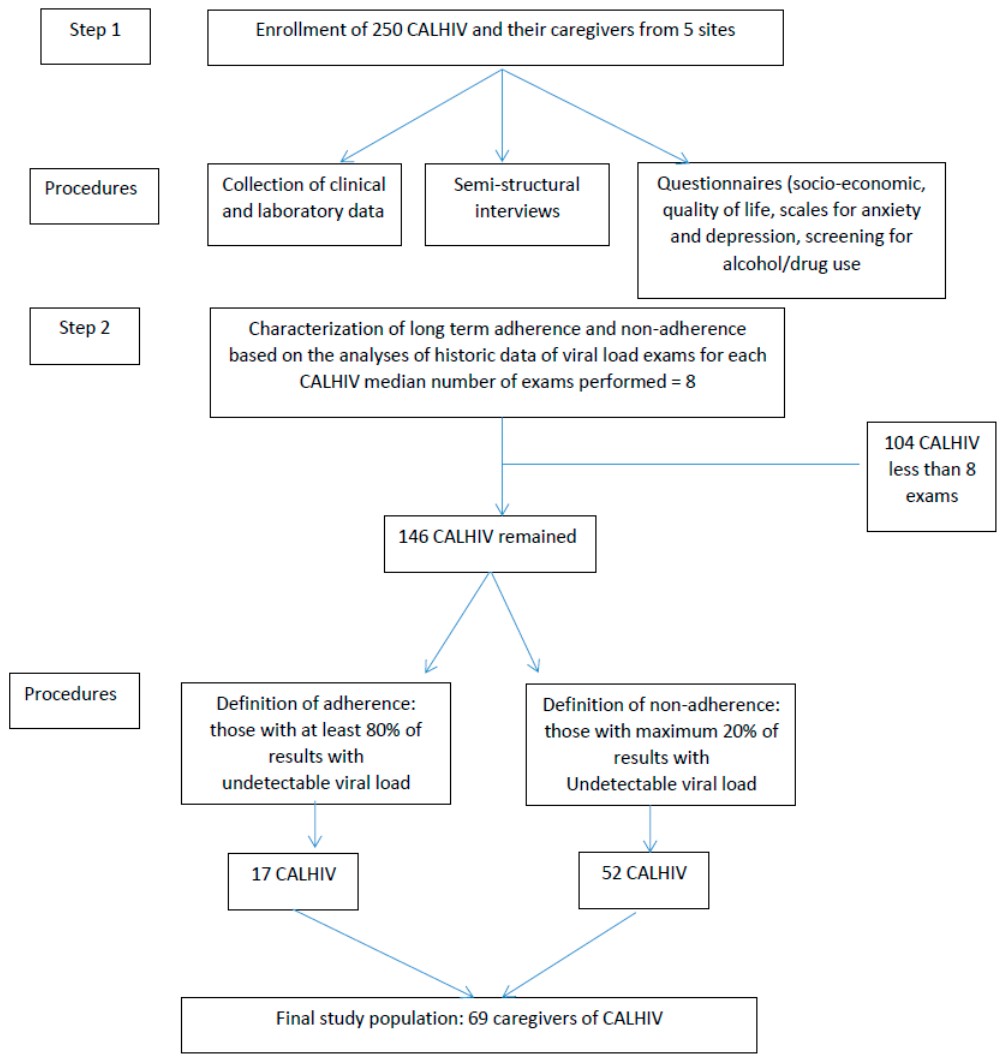
Figure 1. Study design and population.